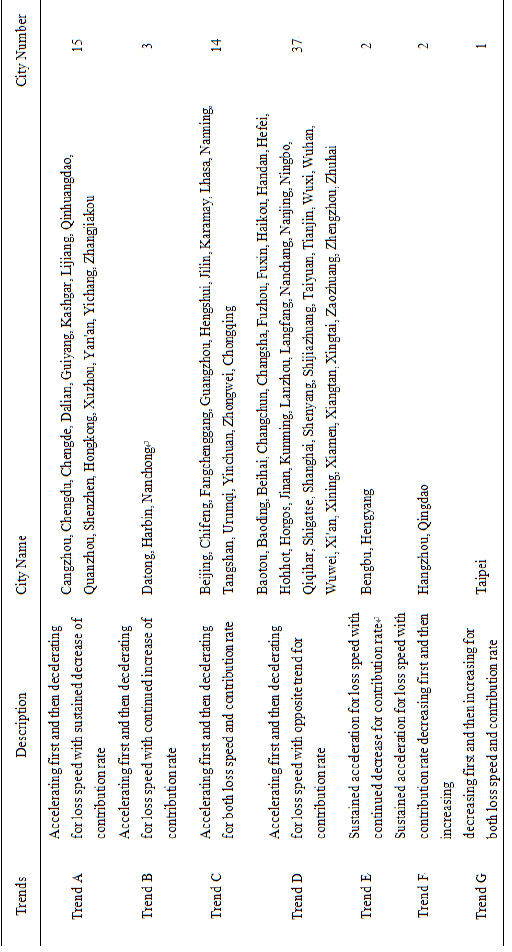
Figure 7 Basic trends classification of cultivated losses among 75 sample